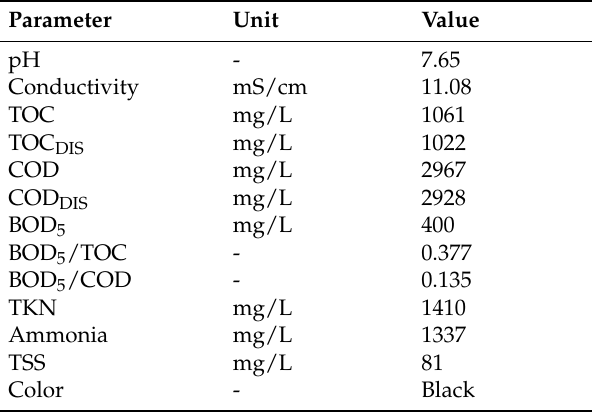
Figure 1. Color evolution of landfill leachates during treatment. From the left: (1) raw leachates; (2) acidified to pH 3.0 after sludge removal; (3) after coagulation with 1000 Fe 3+ mg/L at pH 6.0 and sludge removal; and (4) after the Fe 0 /H 2 O 2 process and sludge removal. Table 1. Raw landfill leachates parameters.